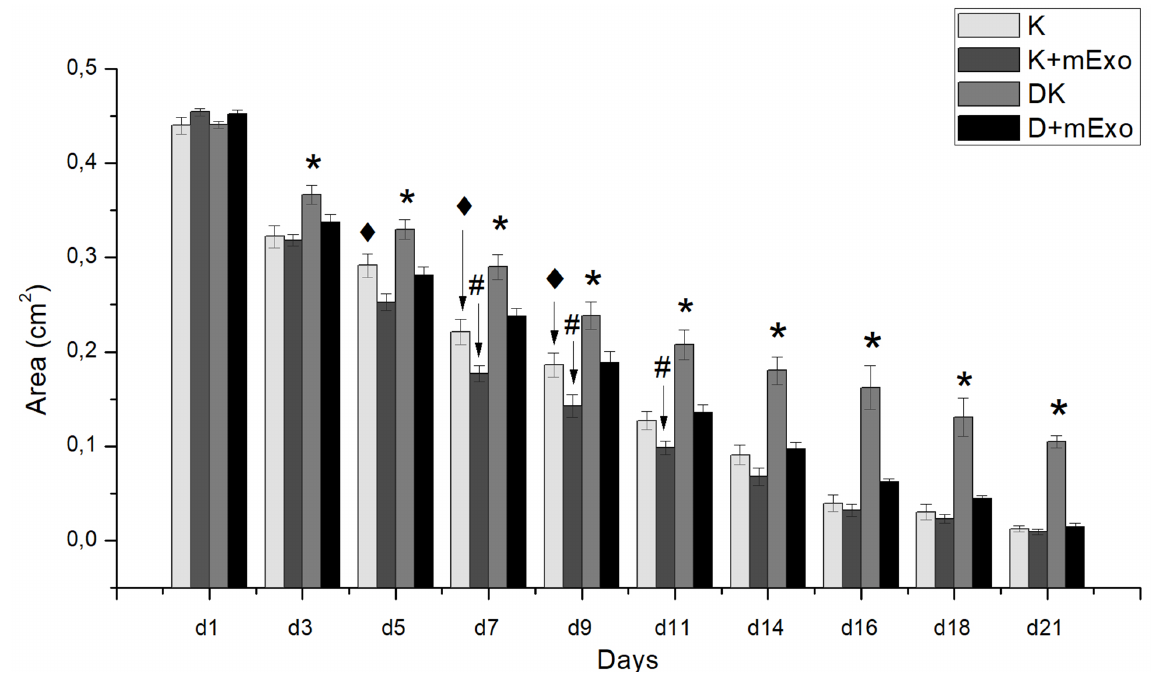
Figure 2. Graph comparing the mean wound areas in the respectively Control, Control Extracellular Vesicles, Diabetic Control, and Diabetes Extracellular Vesicles Groups according to days. C: Control, C+EV: Control Extracellular Vesicles, DC: Diabetic Control, D+EV: Diabetes Extracellular Vesicles. p <0.05 indicates that the difference between the groups in terms of mean values is statistically significant. *: Indicates that there is a statistically significant difference between the DC group and all the other groups (C, C+EV, D+EV). #: Indicates that there is a statistically significant difference between the C+EV and D+EV groups. statistically significant difference between the C and C+EV groups. The error bars shown in the graph indicate the standard error. Represents n = 20 for each